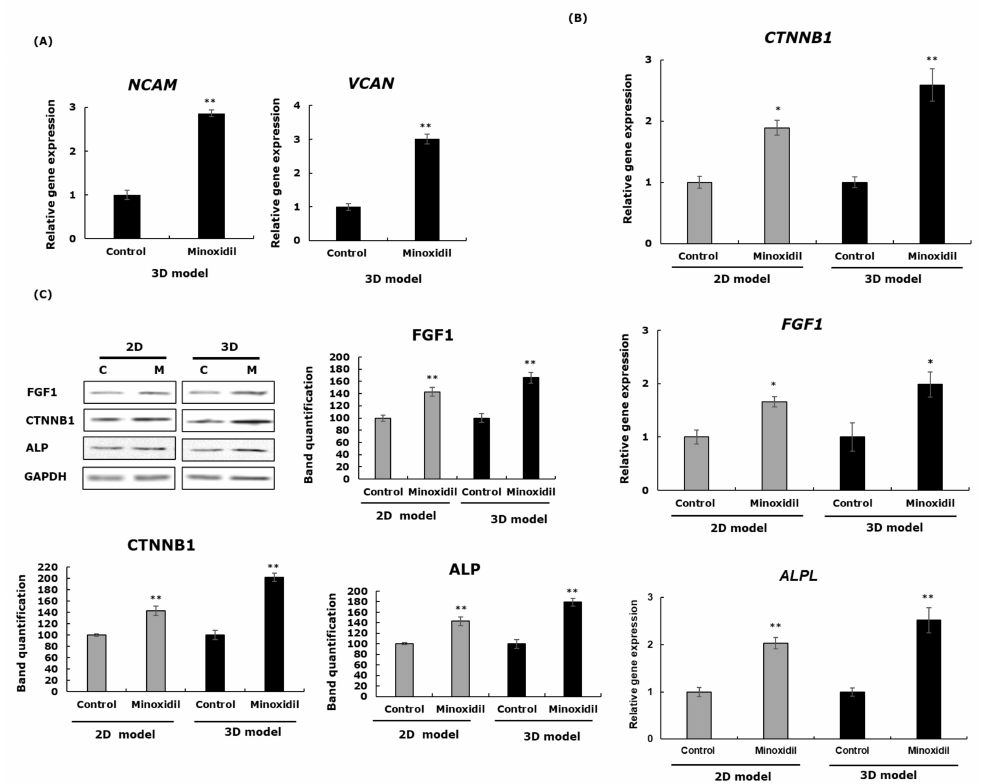
Figure 3. The expressions of ECM and hair growth markers upon minoxidil treatment in the 3D and 2D systems. ( A ) The gene expressions of the ECM markers VCAN and NCAM after 48 h. ( B ) The gene expressions of the hair growth markers CTNNB1, ALPL, and FGF1 after 48 h. For A and B, the mRNA level was quantified using TaqMan real-time PCR. The results represent the mean ± SD of three independent experiments. ( C ) β -catenin, ALP, and FGF1 protein expressions after 48 h. The band intensities were assessed using LICOR. The results represent the mean ± SD of three independent experiments. * p ≤ 0.05, ** p ≤